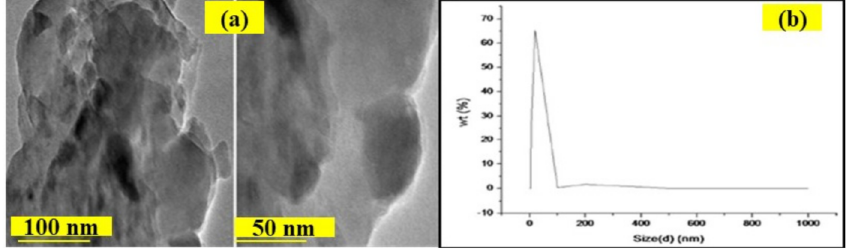
Figure 34. ( a ) TEM images of GS nanoparticles and ( b ) particle size distribution by weight loss (%)